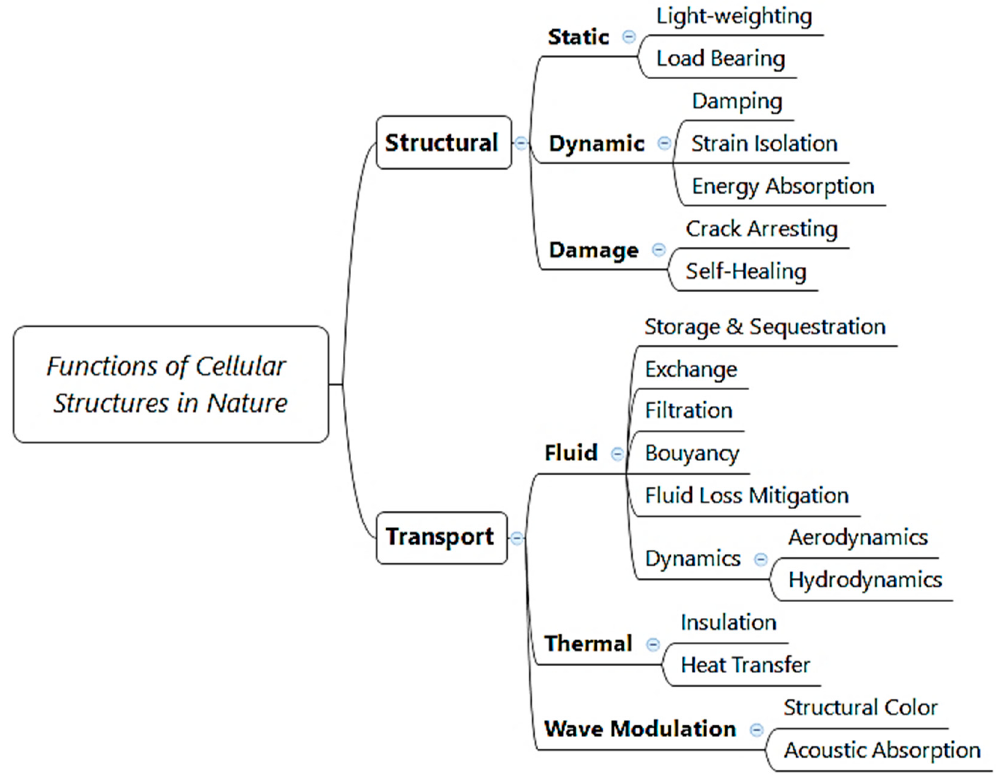
Figure 2. Functions of cellular structures in nature, following [9].